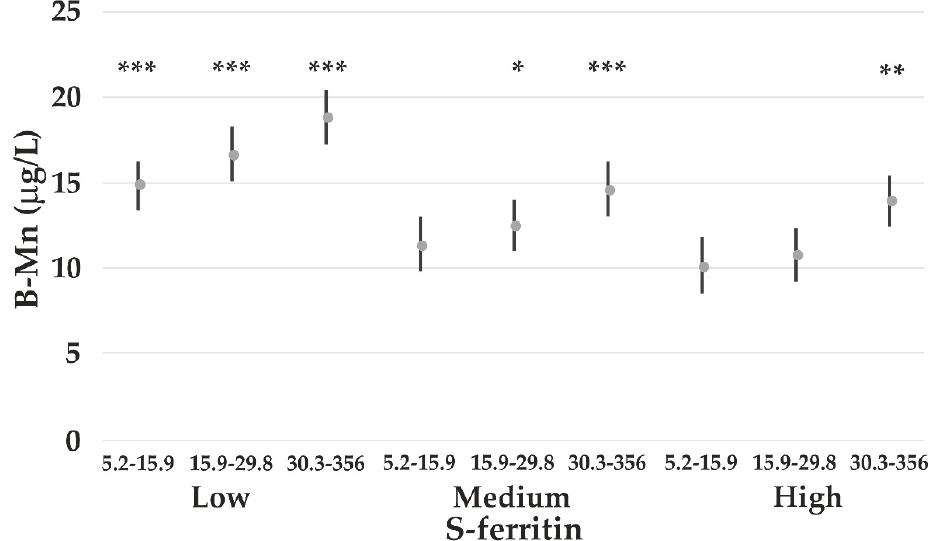
Figure 3. Arithmetic mean B-Mn concentrations among all participants according to S-ferritin divided into tertiles (low 0.5–44 µg/L; medium 45–108 µg/L; high 109–506 µg/L) and B-Pb concentrations (also divided into tertiles). The B-Pb concentration intervals are shown in the figure. The concentrations are adjusted for sex and cloudberry consumption. The p -values (*** p < 0.001; ** p < 0.01; * p < 0.05) refer to comparisons with the subgroup comprising high S-ferritin and low B-Pb.